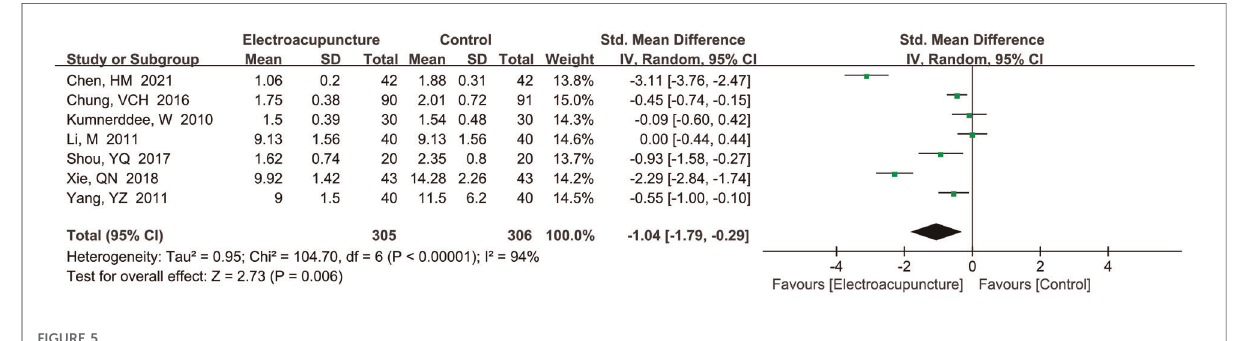
FIGURE 5 A forest plot showing the scores of